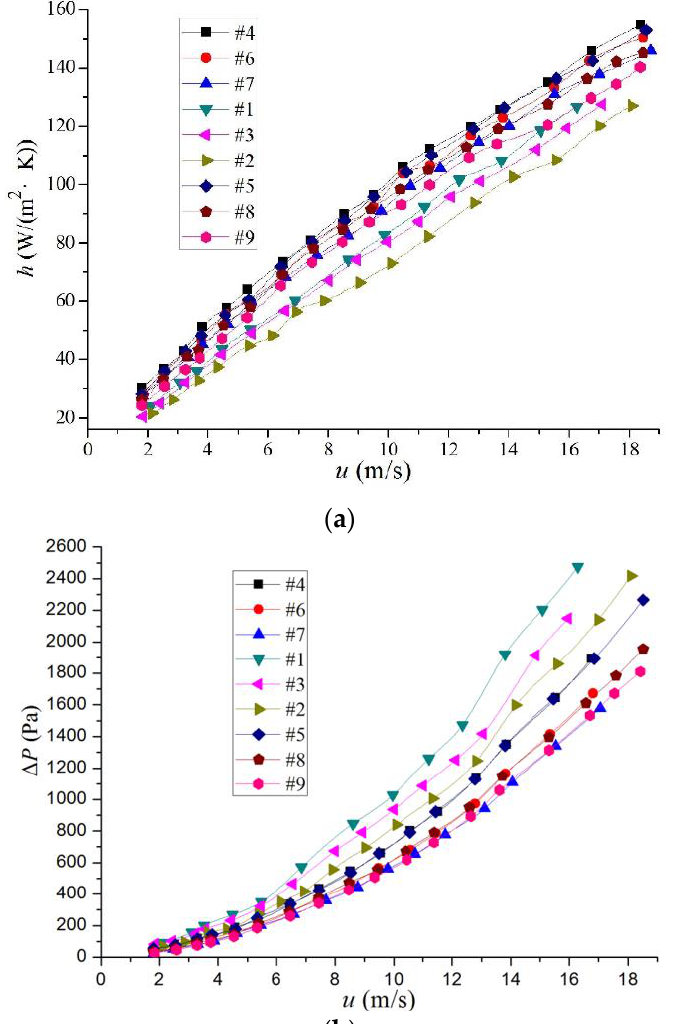
Figure 5. Comparison of heat transfer and flow performance of different circular-arc channels. ( a ) Heat transfer performance; ( b ) flow performance.